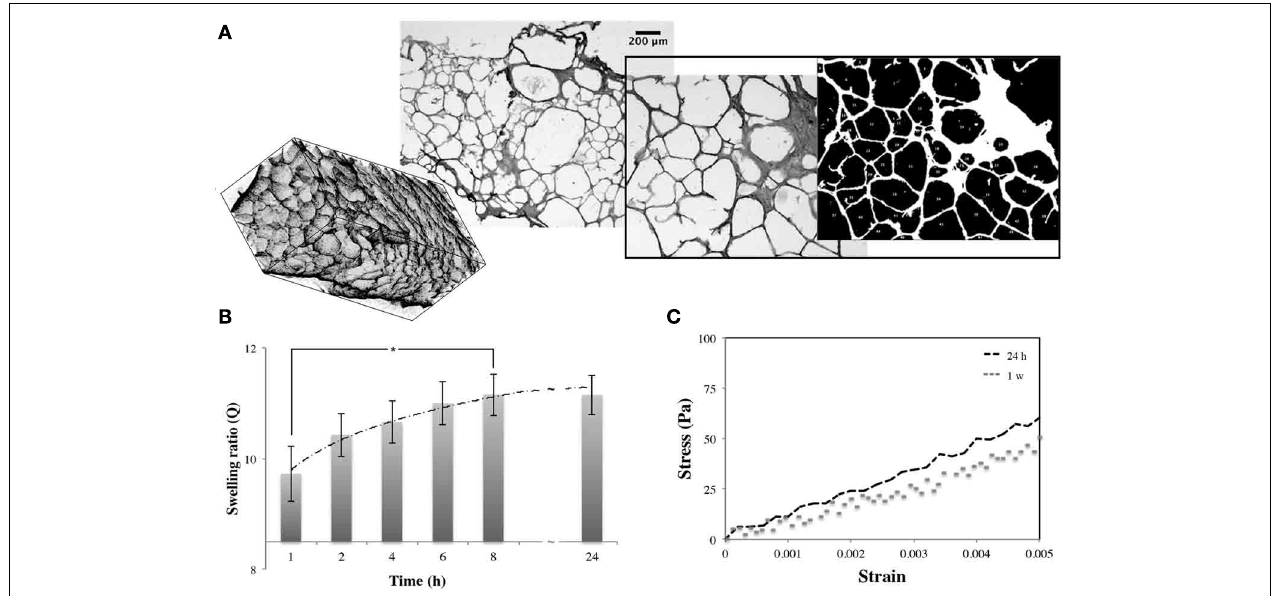
FIGURE 2 | The porous gelatin scaffold. Three-dimensional rendering of scaffold, brightfield images of scaffold section and pore dimension analysis (A) . Modifications of swelling ratio of scaffold over 24h in